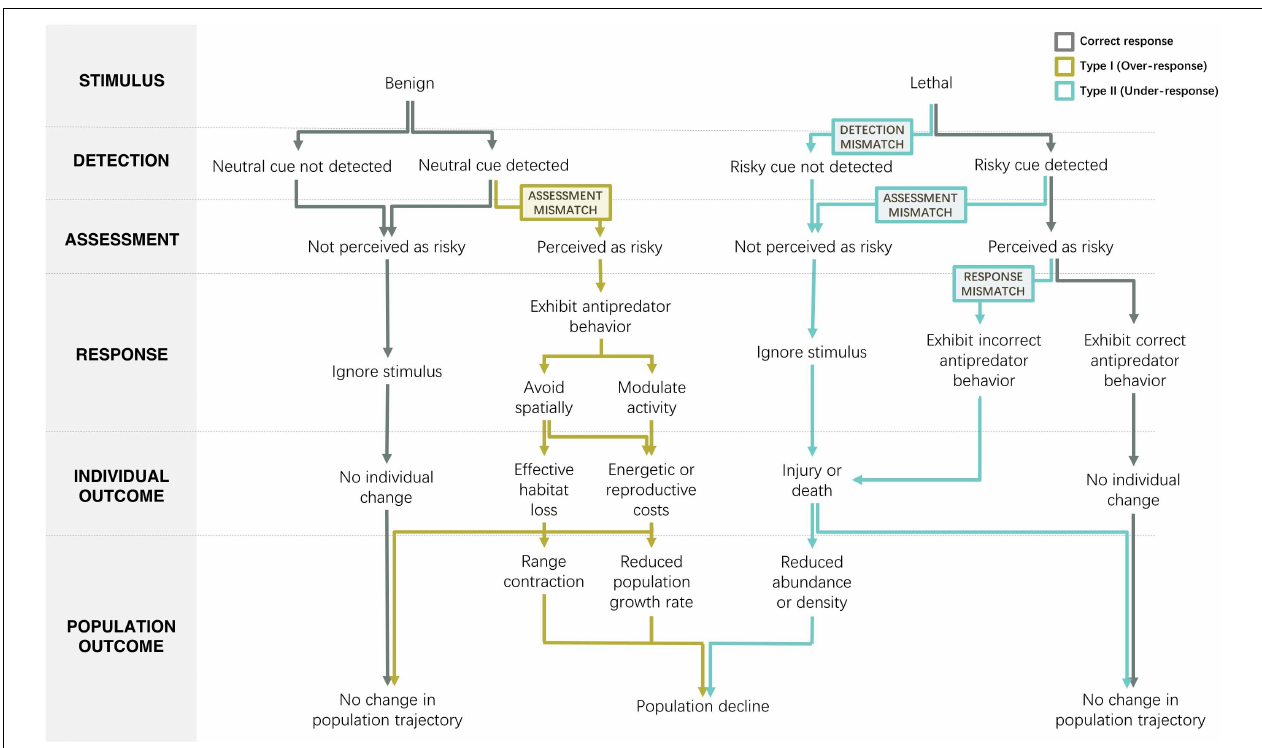
FIGURE 1 | Mismatch in anthropogenic stimuli and animal risk perception and response can lead to population declines. Due to the novel, widespread, and/or unreliable nature of modern anthropogenic cues, animals often fail to align their behavior with the level of risk associated with anthropogenic stimuli. Mismatched risk responses may represent important pathways through which human activity is driving animal declines worldwide. For benign anthropogenic stimuli that pose no threat to the animal, there is the potential for Type I error to occur in the assessment stage if an animal perceives the benign stimulus as risky and responds with unwarranted risk mitigation behavior. Avoiding a benign anthropogenic stimulus in space can reduce habitat utilization, leading to range contraction, and anti-predator responses can also have energetic and reproductive costs that decrease fitness and population growth rates. For lethal anthropogenic stimuli that pose either an intentional or unintentional threat to the animal, the optimal responses pathway may break down at three stages: Type II errors can arise from a failure to detect cues, to assess them as risky, or to respond appropriately. In all cases, an under-response to lethal stimuli can potentially result in injury or death, which may scale up to reduce population abundance and amplify the lethal effects of